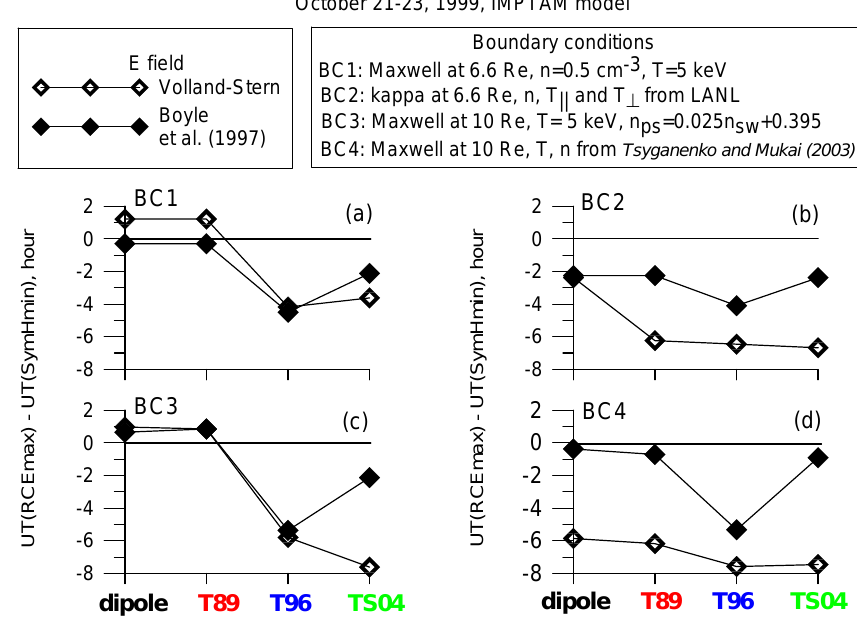
Fig. 7. Times of the peak magnitudes of the ring current energy profiles shown in Fig. 3 during 21–22 October 1999 storm, similar to Fig. 6. Table 2. Model-dependent storm-time ring current: peak values and their UTs. Moderate storm Intense storm Peak